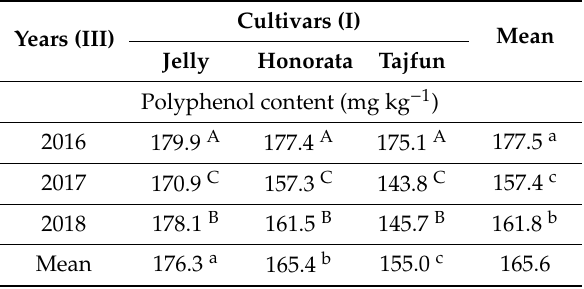
Table 6. Ccontent of polyphenols in the fresh mass of potato tubers depending on the cultivars (I) in the years of research (III) (mg · kg − 1